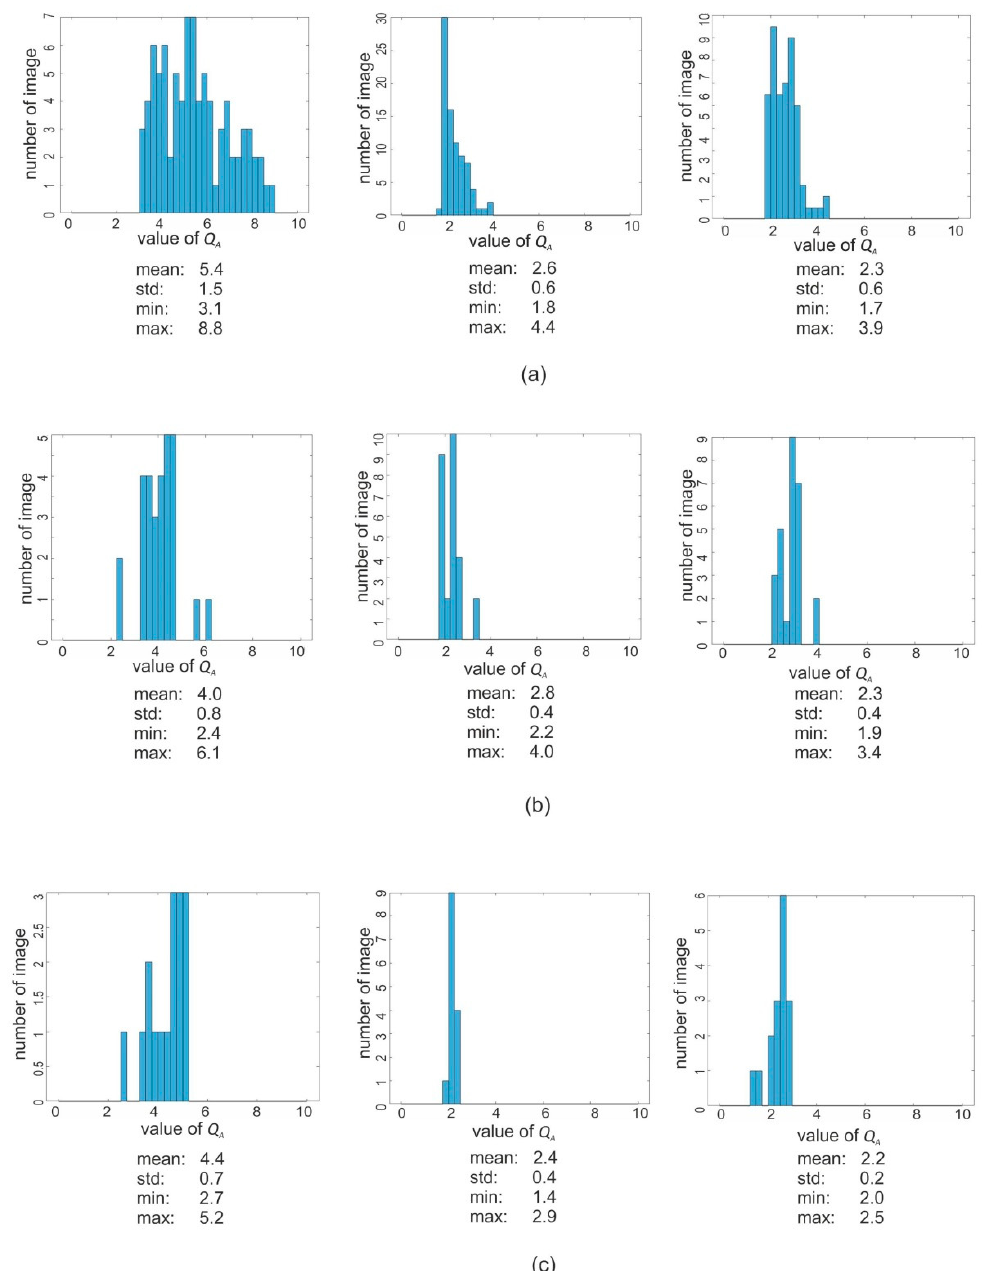
Figure 14. Distribution of the Q A indicator values for reference data acquired (left to right): morning, noon, and evening, at ( a ) 50 m, ( b ) 100 m, and ( c ) 150 m .